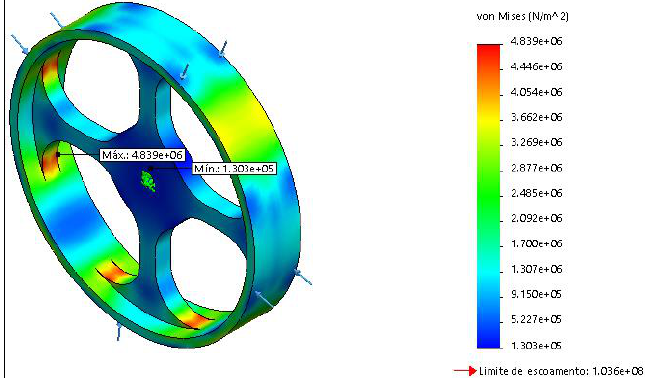
Figure 7: Result of Von Misses tension.